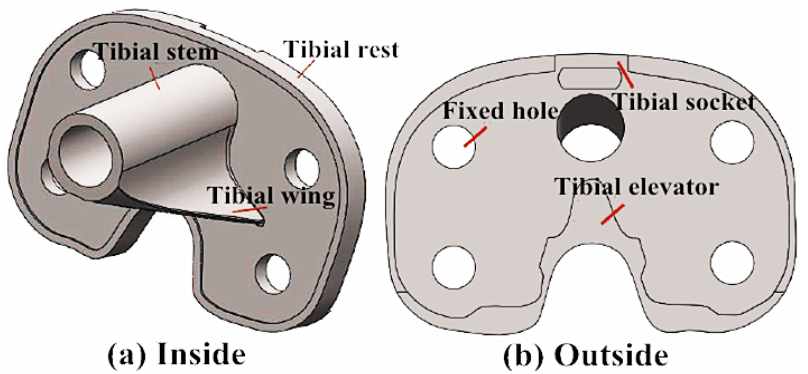
Figure 4. Solid model of personalized tibial implant: ( a ) Stereogram of tibial prosthesis; ( b ) Overlook of tibial prosthesis.